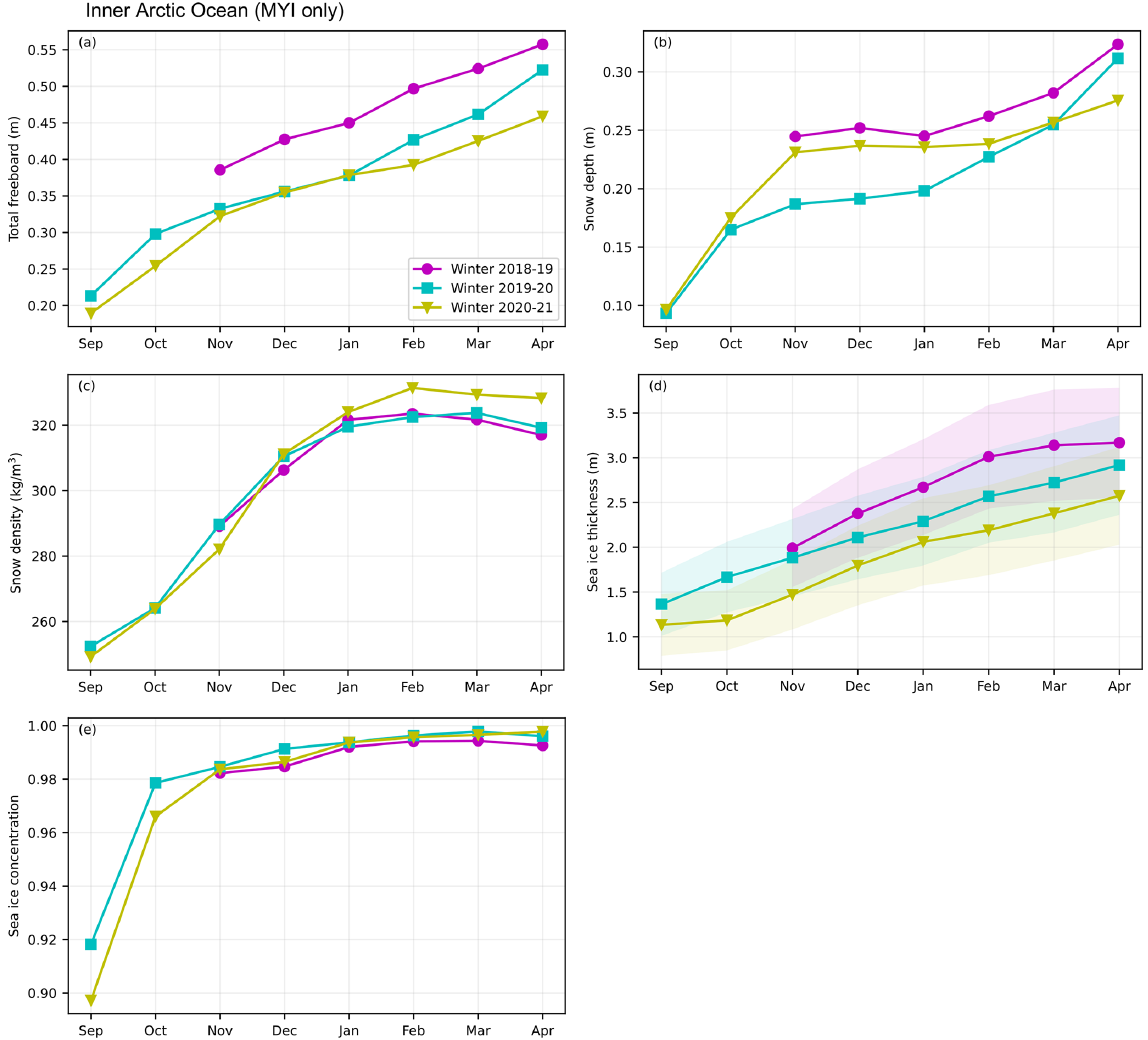
Figure 16. As in Fig. 12 but for monthly means of grid cells identified as multiyear ice (MYI) only based on the OSI SAF ice type product (no September ice type information is provided, but we assume it is all MYI